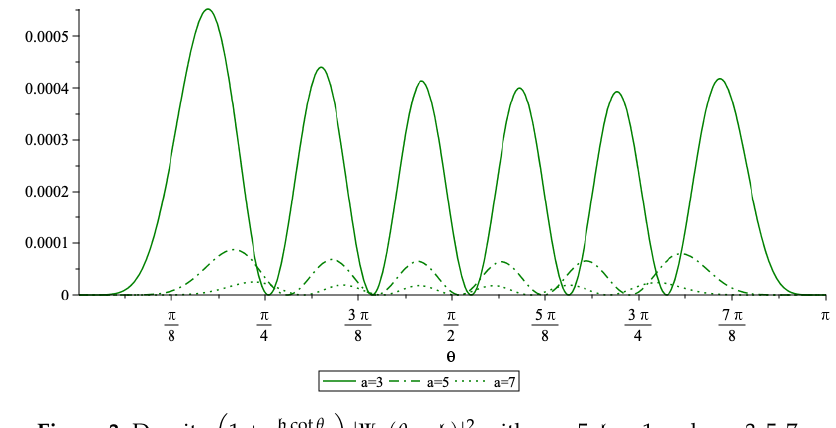
Figure 3. Density